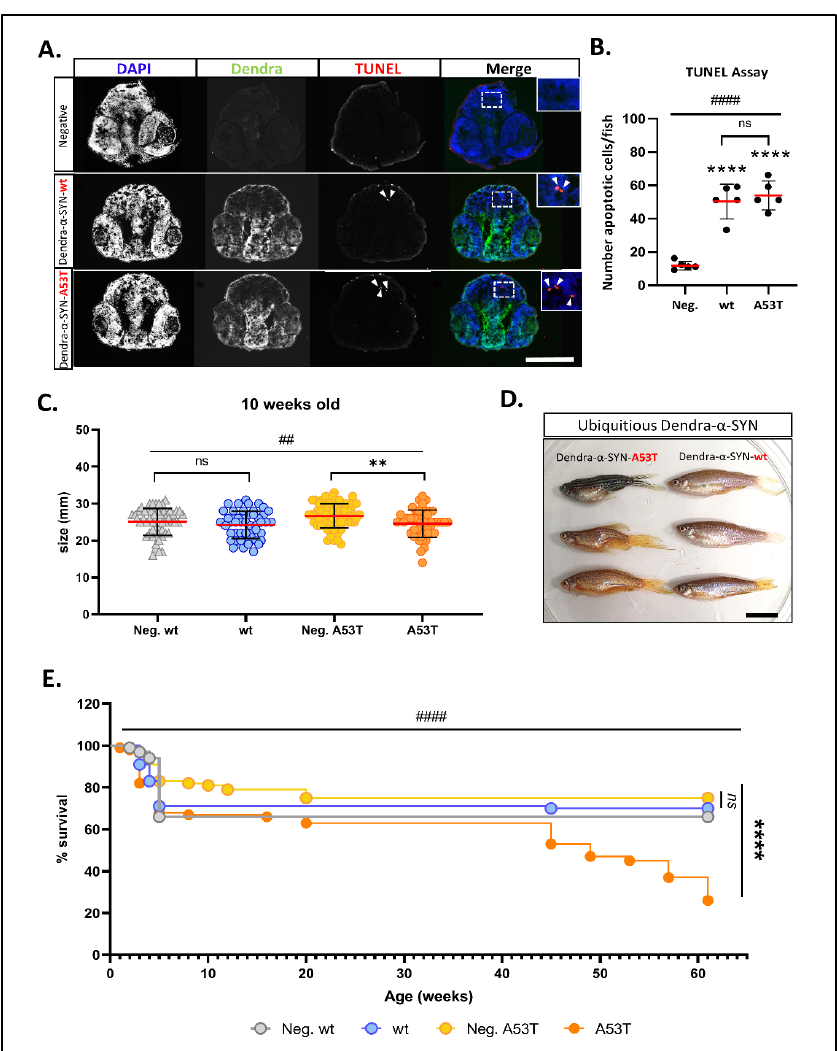
Figure 2. Characterisation of neuronal pathology and longevity in Dendra- α -SYN transgenic zebrafish. ( A ) Representative images of TUNEL labelling in the brains of larvae at 2 d.p.f. Pictures show DAPI, Dendra and TUNEL in transverse cryosections across the heads of embryos with pan- neuronal expression of Dendra- α -SYN-wt and A53T, compared to transgene-negative siblings imaged by epifluorescence microscope. Apoptotic nuclei are highlighted by white arrowheads in TUNEL images and shown at higher magnification in merge images. Scale bar represents 250 μm. ( B ) Quantification of the total number of apoptotic cells in 5 sections per fish detected by TUNEL assay. A significant increase in cell death was seen in fish expressing Dendra- α -SYN-wt (wt) or the A53T mutation, compared to transgene-negative siblings (Neg.). Data represented as mean (red line) ± s.d. ( N = 5 fish per group, **** p < 0.0001 Dendra- α -SYN transgenics vs. Neg.; ns p > 0.05 Dendra- α -SYN-wt vs. A53T; #### p < 0.0001 ANOVA). ( C ) Graph represents the differences in body